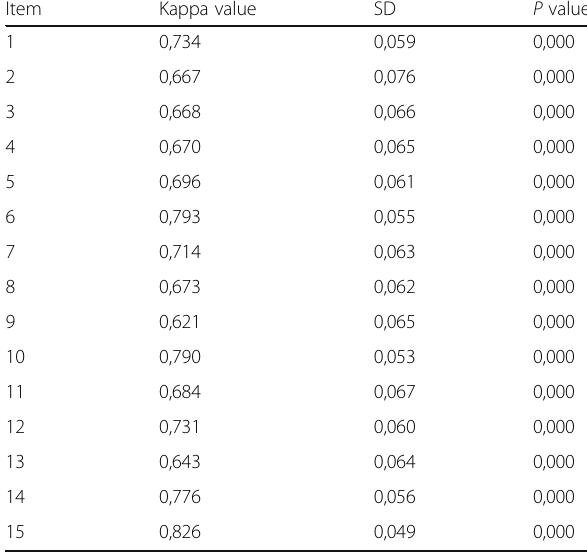
Table 3 Intra-observer reliability